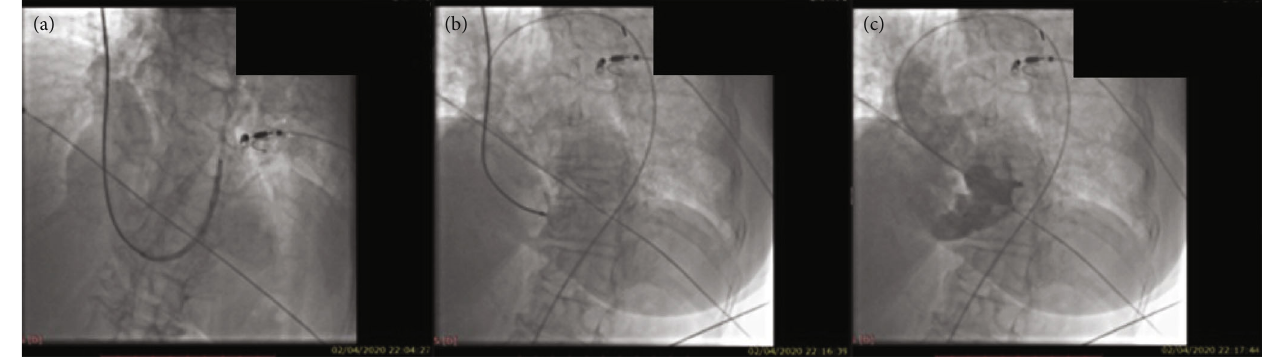
Figure 3: (a) and (b) Successful implantation of a 24mm MemoPart ™ device across the VSR. (c) Ventriculography showing mild to moderate residual